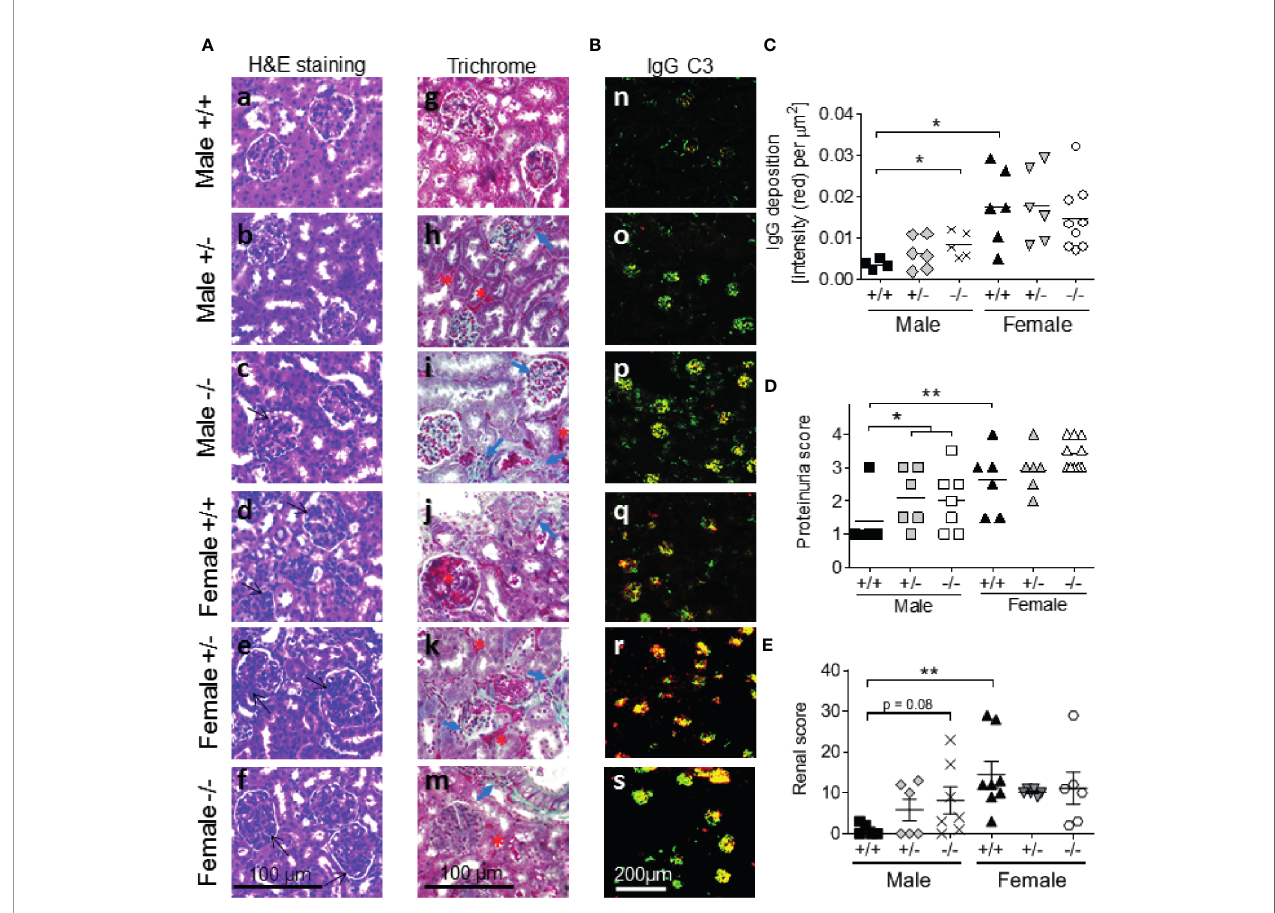
FIGURE 6 | S100a9-de fi ciency promotes proteinuria and renal damage in male BWF1 mice. Kidneys were harvested from eight month old BWF1 lupus-prone mice ( n = 5-11) and stained. (A) H&E (a-f) and Masson ’ s Trichrome (g-m) were performed to assess glomerulonephritis, mesangial proliferation (black open-head arrows), interstitial in fl ammation, tubular atrophy, collagen deposits (blue closed-head arrows), and cast formation (red asterisk). All images were taken at similar settings and magni fi cations. (B, C) Deposition of IgG-immune complexes (red) and fi xation of complement factor 3 (green) were determined by immuno fl uorescent staining of kidneys ( B , n-s). Colocalization of IgG and C ’ 3 can be seen as yellow. IgG deposition was quanti fi ed (C) . (D) Proteinuria readings at the time of harvest. (E) Renal histology scores. Each symbol represents one individual mouse. *p < 0.05; **p < 0.01, Student ’ s unpaired t test with Welch ’ s correction (C, D) , Student ’ s paired t- test (E) . One-way ANOVA: p < 0.01 (C) , p < 0.01 (D) and p < 0.01 (E)